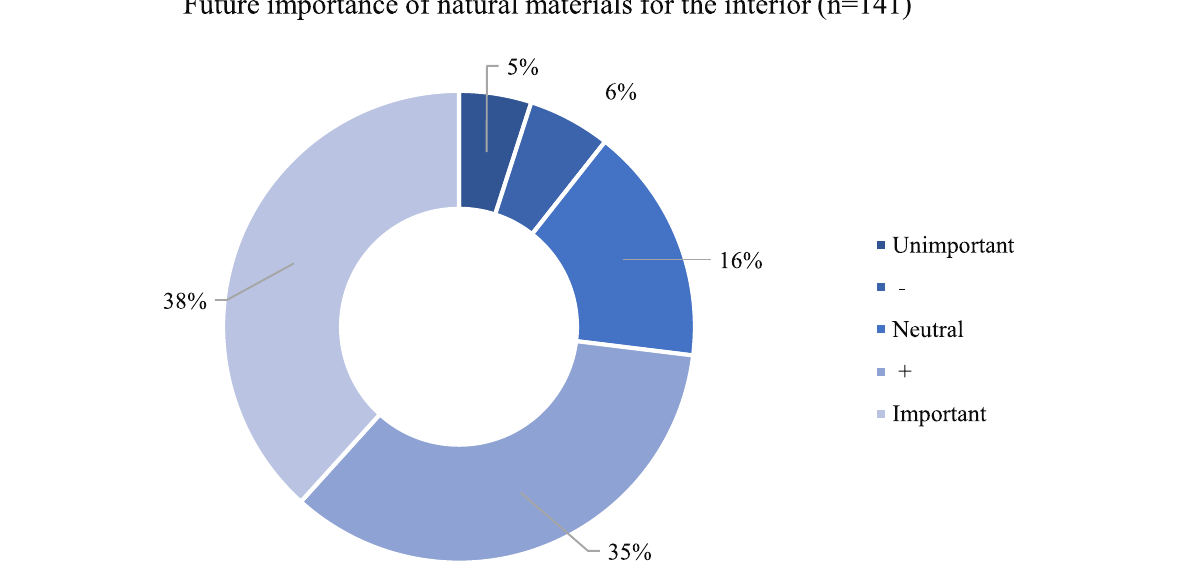
Fig. 10 Future importance of natural materials for the interior ( n = 141). Source: Own